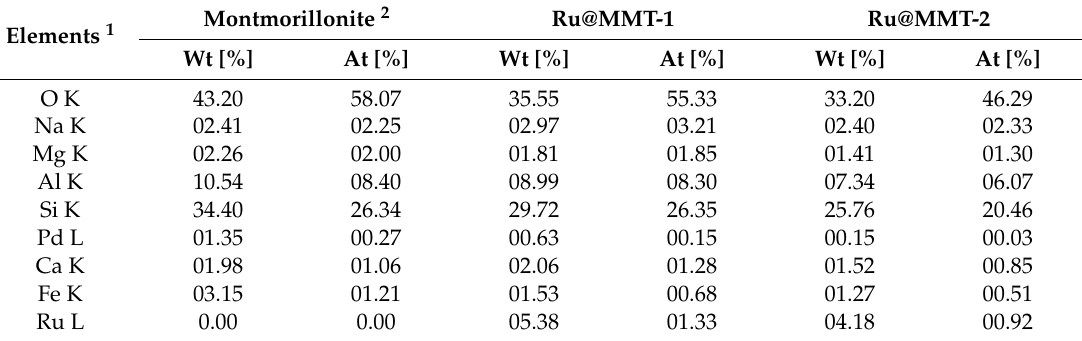
Table 3. The detail EDX spectrum data analysis of Ru@MMT-1 and Ru@MMT-2 compared with pure